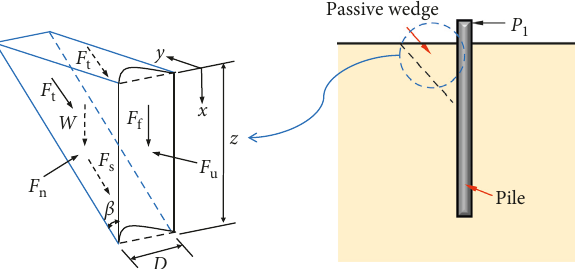
Figure 2: Mechanical analysis of passive soil wedge.